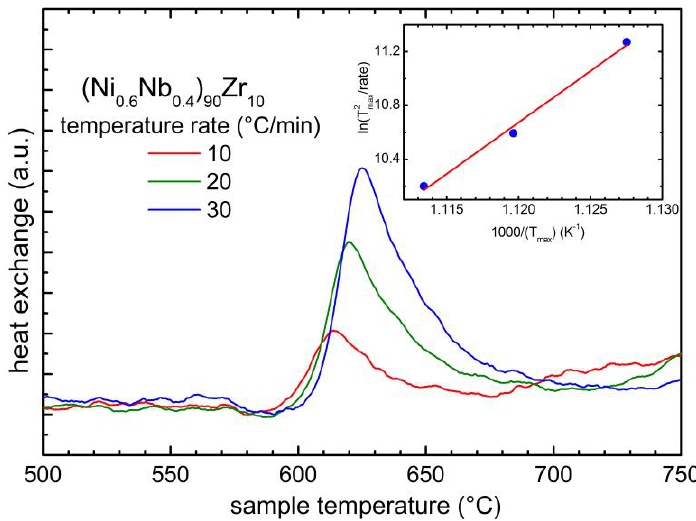
Figure 2. DTA curves of sample (Ni 0.6 Nb 0.4 ) 90 Zr 10 , measured at various temperature rates. The inset shows the Kissinger plot for the crystallization peak and the best fit line.